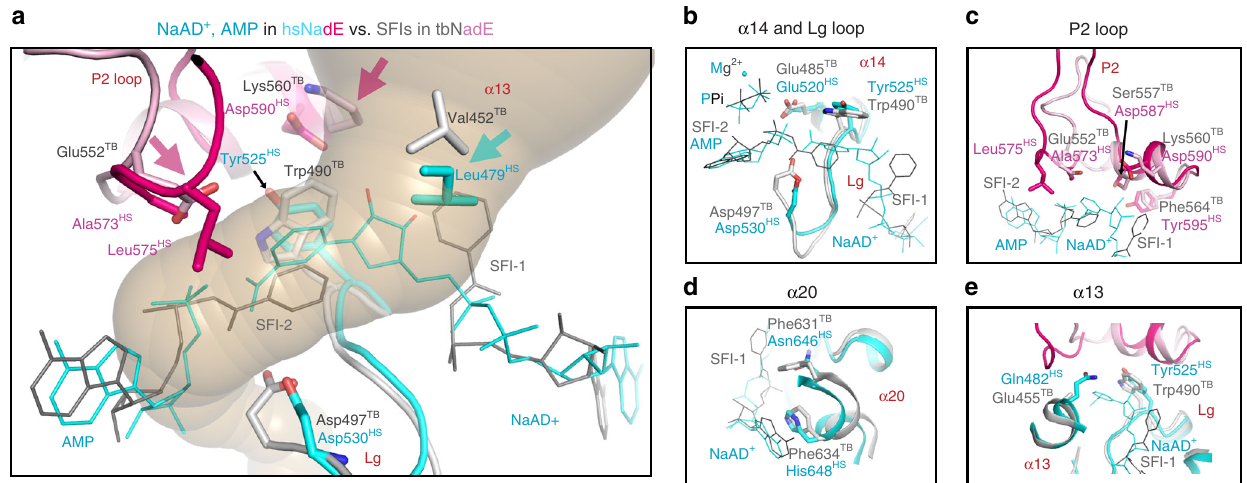
Fig. 8 Implication for drug design speci fi c to tbNadE. a Overlay of tbNadE and hsNadE complexes. NaAD + shown with AMP in hsNadE in cyan and SFIs in tbNadE in gray (PPis are omitted for clarity). The P2 loop residues are pink and light pink in hsNadE and tbNadE, respectively. Residues important for future anti-TB drug design are shown as sticks. Pink and cyan arrows highlight the residue with the biggest difference in size and/or character between homologs. b – e Comparison of the synthetase-binding site between homologs at α 14 and the Lg loop ( b ), P2 loop ( c ), α 20 ( d ), and α 13 ( e hsNadE was incubated at 27°C for 72h at 120 rpm, harvested by centrifugation at insert and was then puri fi ed by agarose gel. The puri fi ed insert was annealed to a 500× g for 5min at room temperature and stored at − 80°C until puri fi cation. linear pI-SUMOstar vector with a ratio of 2.5 μ L vector to 2 μ L insert in a ther- mocycler according to manufacturer ’ s speci fi cations and transformed into Gene- Hogs E. coli cells (Invitrogen). DNA sequencing con fi rmed the correct construction of pISUMOstar- hsNadE . The recombinant bacmid was obtained by the transfor- mation of 1ng pISUMOstar- hsNadE into DH10Bac competent cells (Invitrogen), which was selected using the blue/white screening and was cultured for bacmid extraction.